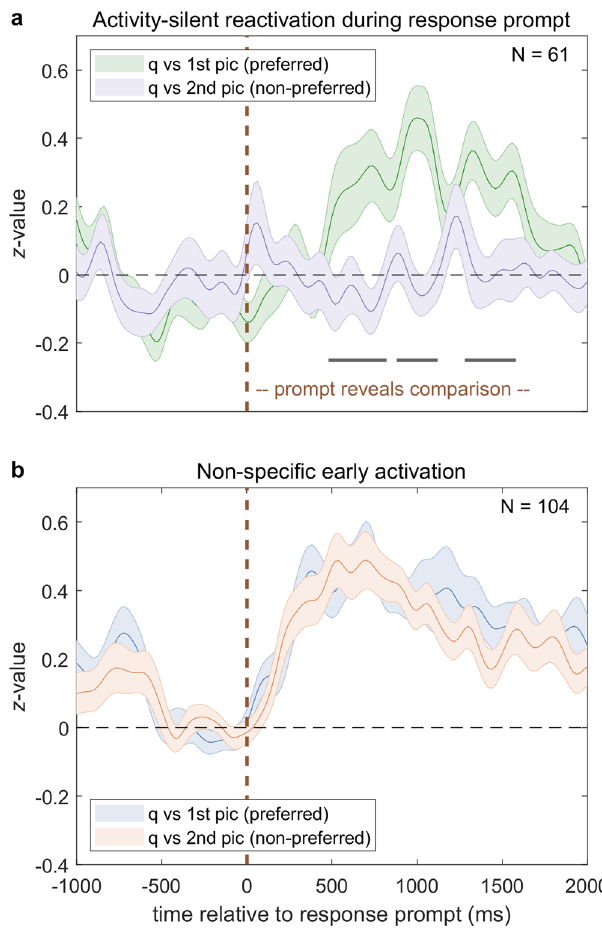
activation. Concept neurons are reactivated after activity silence ( a ) following non-speci fi c activation ( b ) whenever attention is directed back towards their preferred concept. a Averaged normalized fi ring rates of all concept neurons with standard errors (shaded areas) in the question- comparison condition during the presentation of the response prompt at the end of each trial (see Fig. 1b) whenever the fi rst picture was preferred. The response prompt (onset: vertical dashed line in dark red) asked for a comparison between the concept of the question (non-preferred) and either that of the fi rst (preferred, green) or that of the second picture (non- preferred, violet). Normalized activity differed signi fi cantly between these two response prompts ( p <0.05; two-sided cluster permutation test, black) and concept neurons were reactivated only if the prompt referred back to the preferred concept (green). Following complete activity silence, reactivations began 500ms after presentation of the response prompt (see also reactivation window in Fig. 5a). b Same as a but with averaged normalized fi ring rates of non-visually-selective neurons whose z -value exceeded one during the response prompt (0 – 1500ms; onset: vertical dashed line in dark red). Blue and red again denote comparisons to fi rst (blue) or second (red) picture concepts. Activity sharply increased after ~250ms, roughly 250ms before reactivations of concept neurons, and did not differ between the two response prompts ( p <0.05; two-sided cluster permutation test). Data are presented as mean values±SEM ( a , b ) with solid lines and shaded areas, respectively. Source data are provided as a Source Data fi